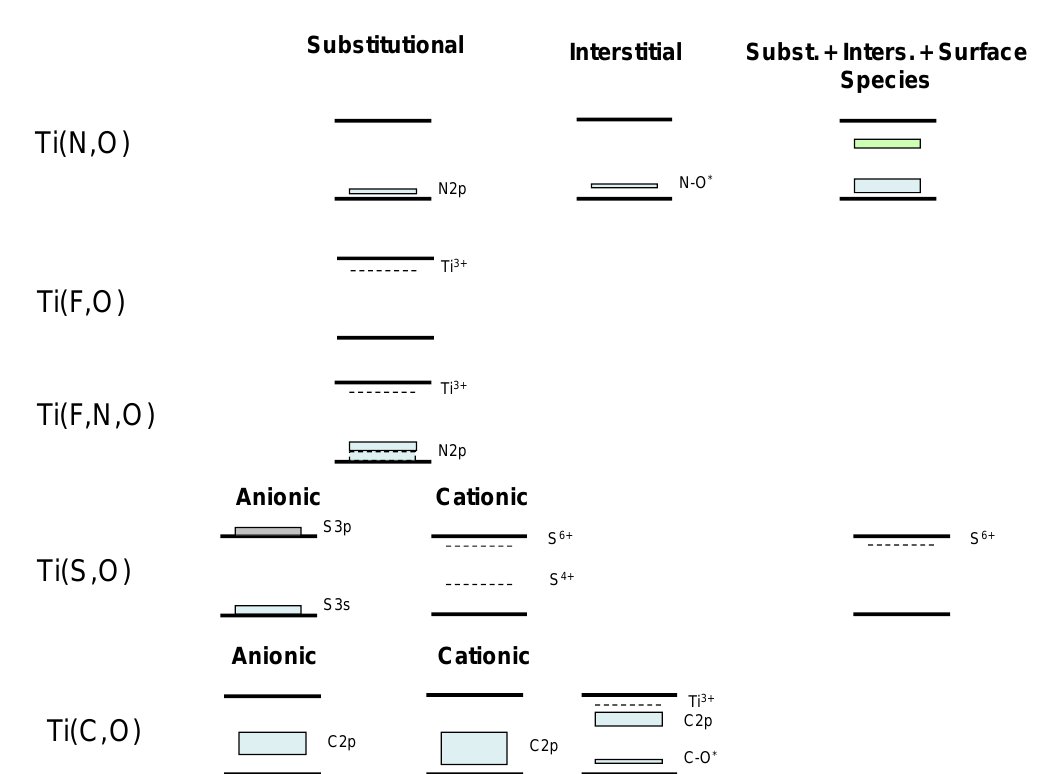
Figure 3. Schematic representation of the electronic effects generated by non-metal doping in anatase-based systems.